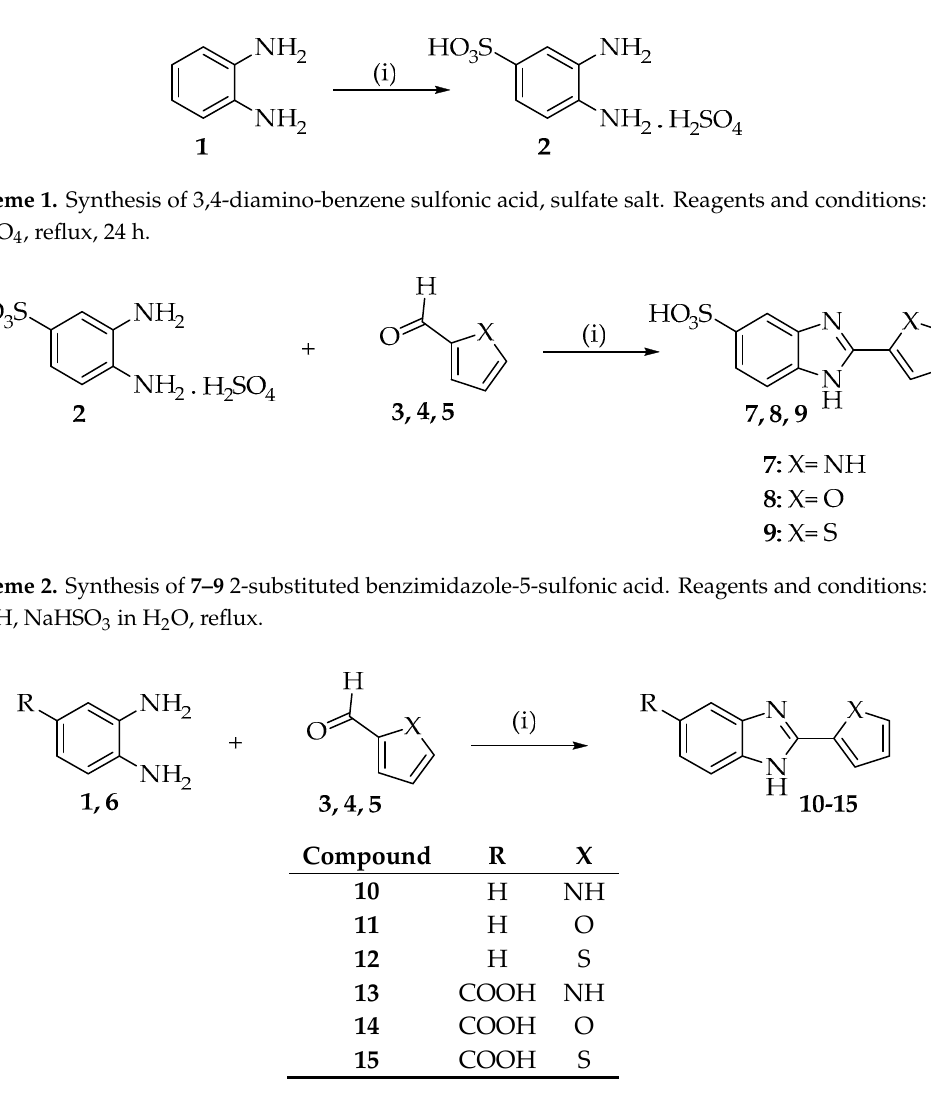
Scheme 3. Synthesis of 10 – 15 benzimidazole derivatives. Reagents and conditions: (i) EtOH, NaHSO 3 in H 2 O, reflux.